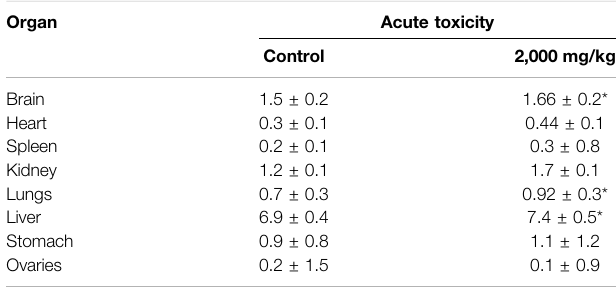
TABLE 1 | Effect of different doses of SF5 treatment on the organ weights of selected organs in acute toxicity studies. Organ